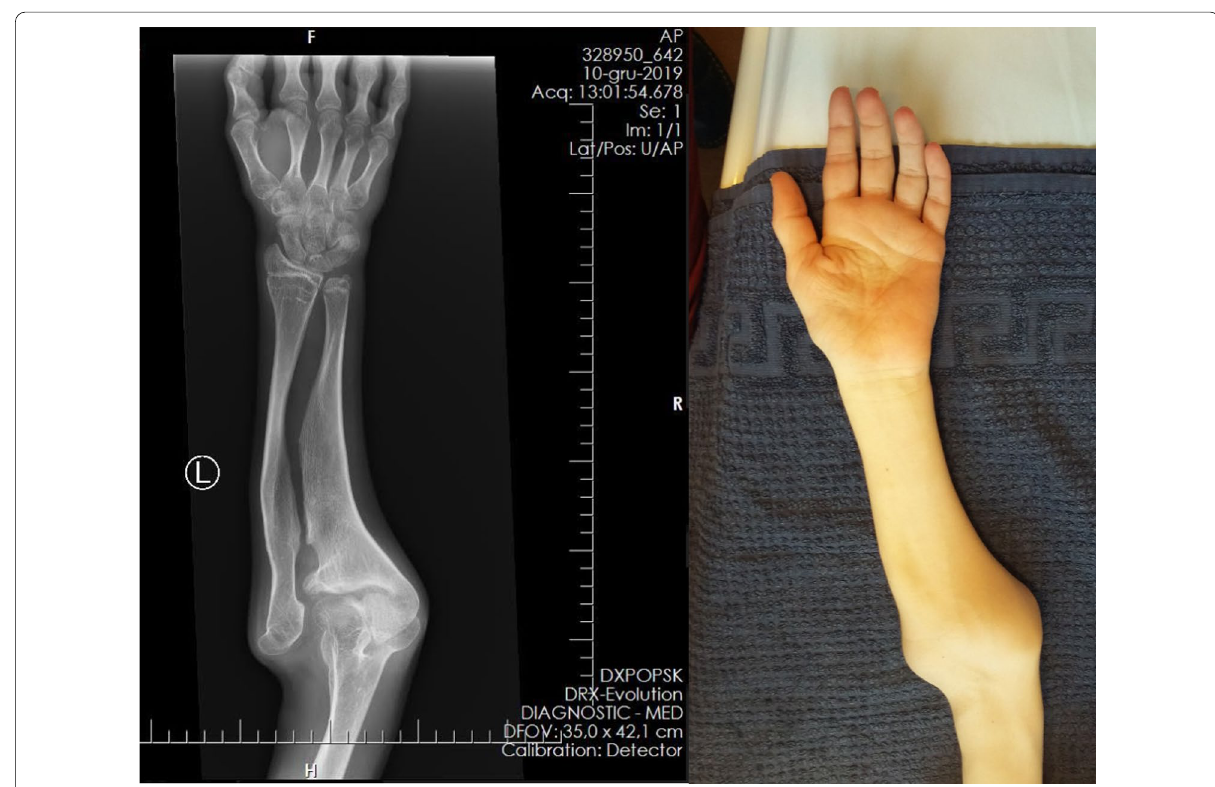
Fig. 2 Photograph and X-ray of the left upper limb before